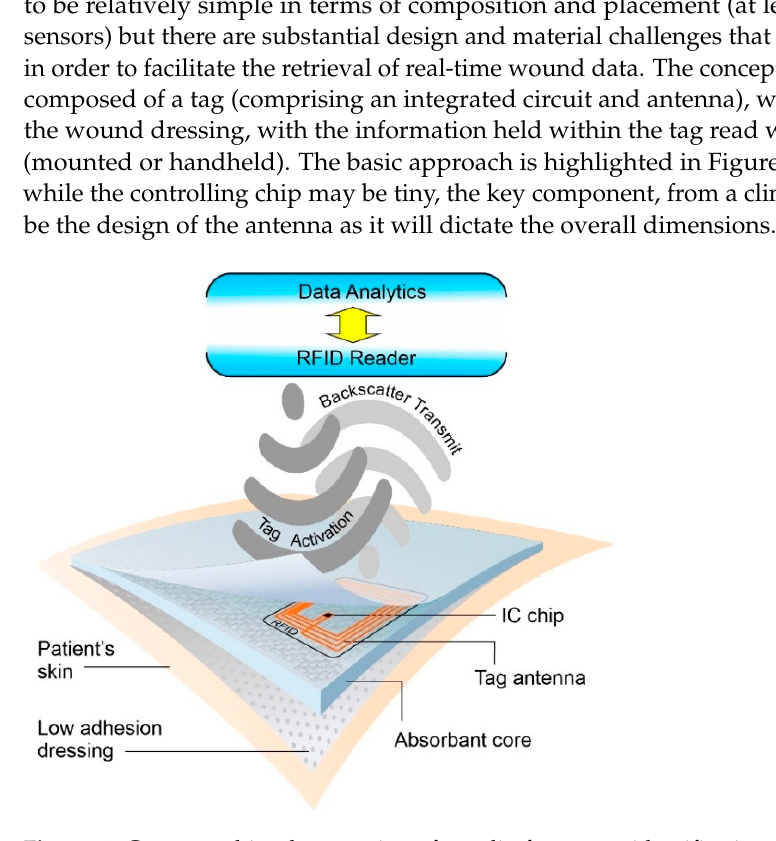
Figure 4. Conceptual implementation of a radio frequency identification (RFID) sensor within a wound dressing.